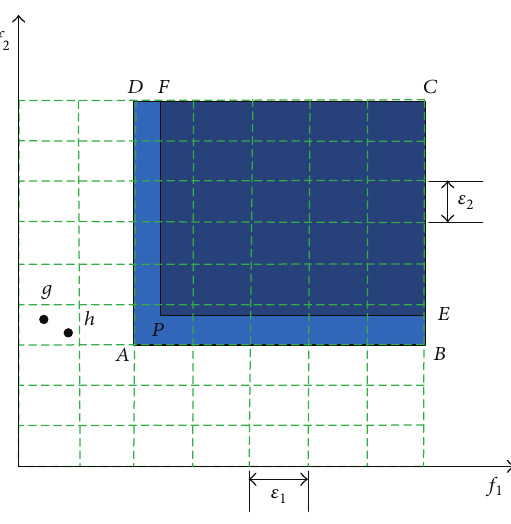
Figure 2: The 𝜀 -dominance concept.